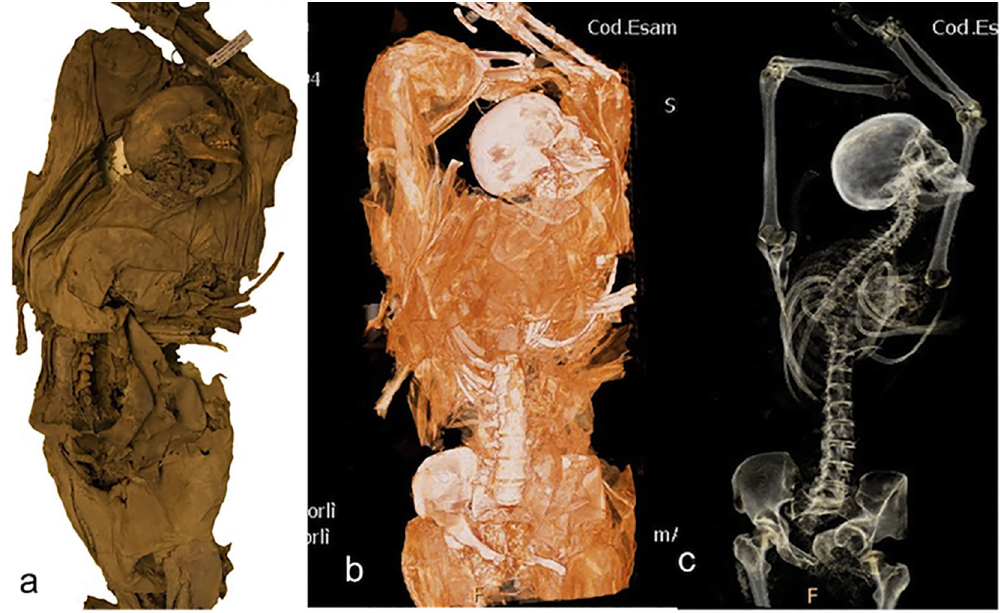
Fig 9. IND 50: female with estimated age of about 20 – 29 years old. Picture of the mummy (a). VR reconstructions with soft tissue filter of visualization (b) and VR with bone filter of visualization (c).